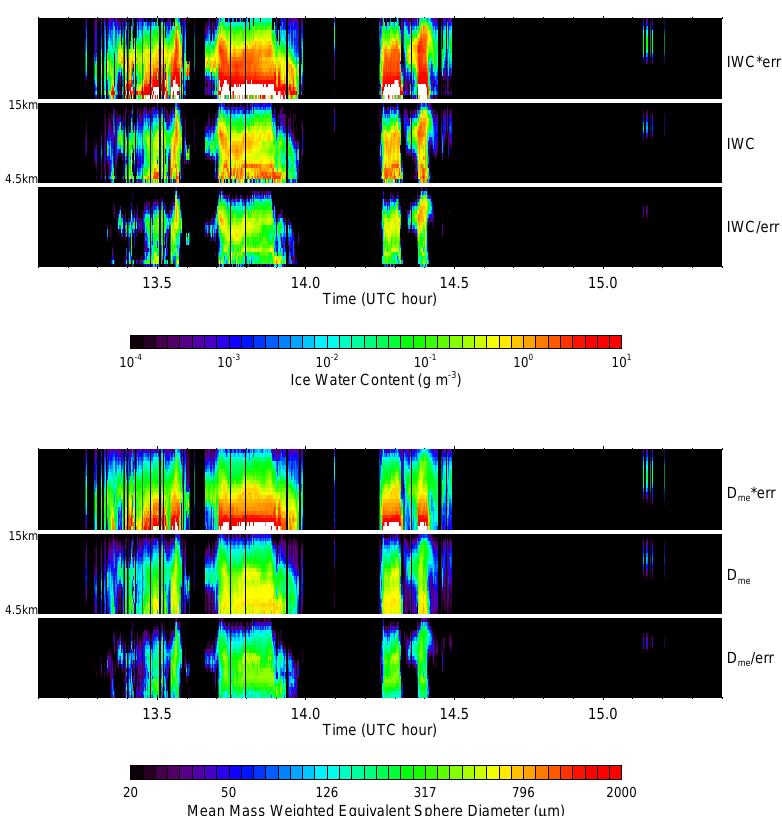
Fig. 19. Ice water content and D me profiles retrieved from nadir CoSSIR data. For each variable the middle time-height cross section is the retrieval, and the upper and lower images show the one standard deviation error